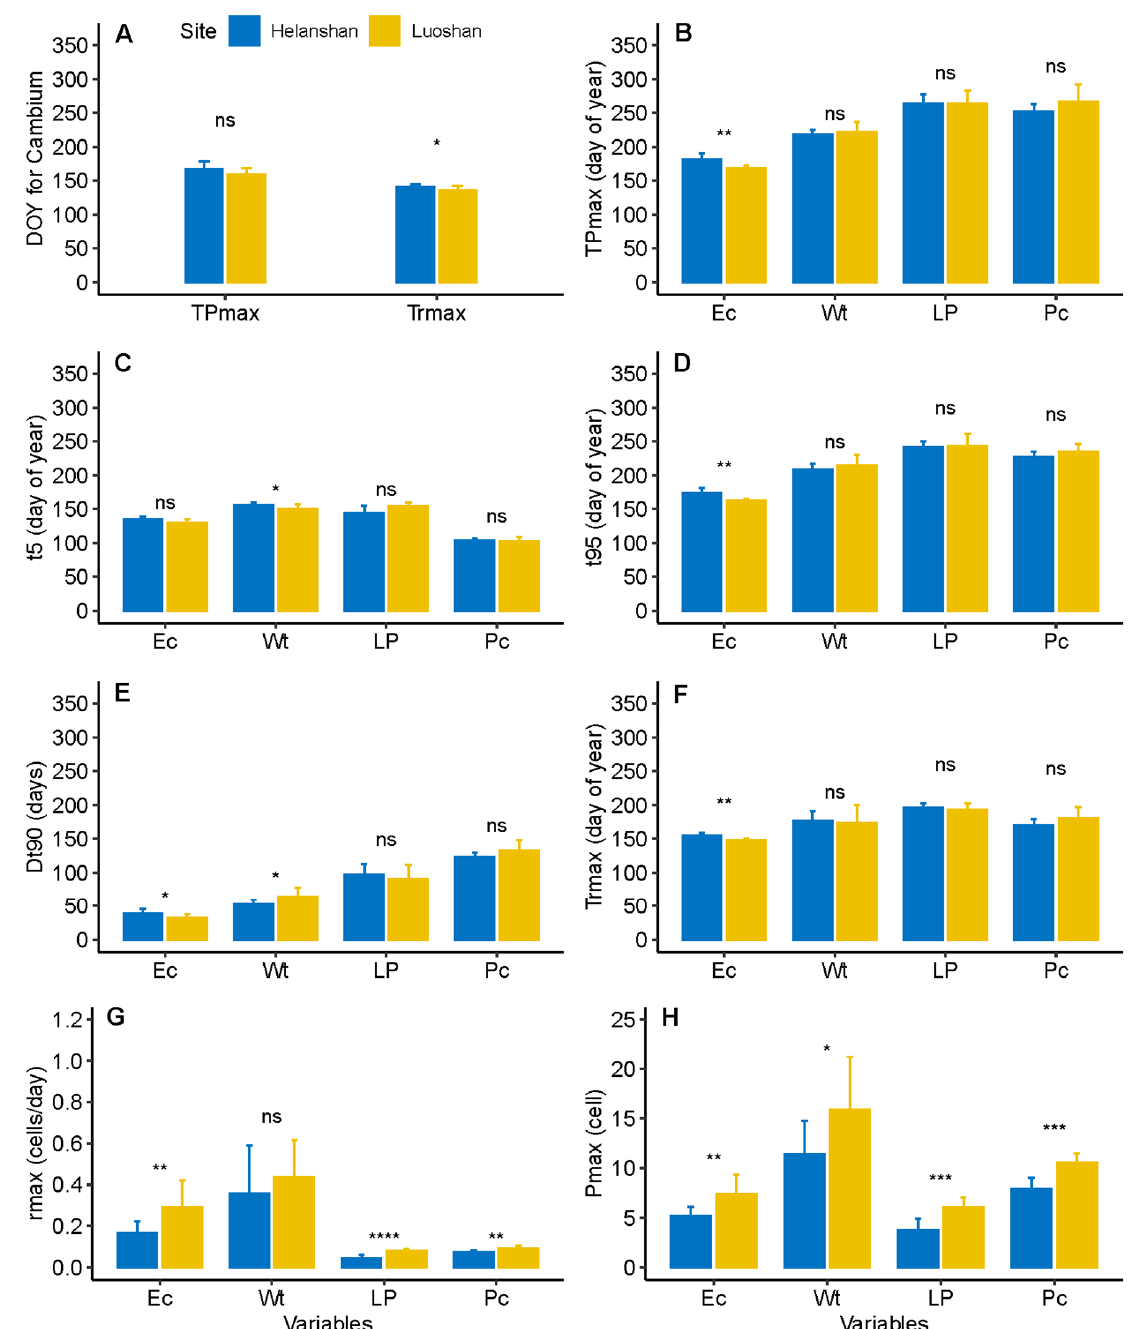
Figure 4. Biological parameters of xylem and phloem formation computed from generalized addi- tive models (GAMs). Ec, Wt, LP, and Pc are the enlarging, wall thickening, late phloem, and total phloem cells, respectively. TPmax ( A , B ) is the date that Pmax appeared; t5 ( C ) and t95 ( D ) represent the first date for 5% of maximum production and 95% of maximum production, respectively; Dt90 ( E ) is the duration between 5% and 95% of the maximum produced; Trmax ( A , F ) is the date maximal growth rate appeared; rmax ( G ) is the maximum growth rate computed from the first derivative of fitted GAM and Pmax ( H ) is the maximum predicted cell production. Values are presented as mean ± SD. *, **, ***, and ns represent significant levels at p < 0.05, p < 0.01, p < 0.001, and p > 0.05, respec- tively.